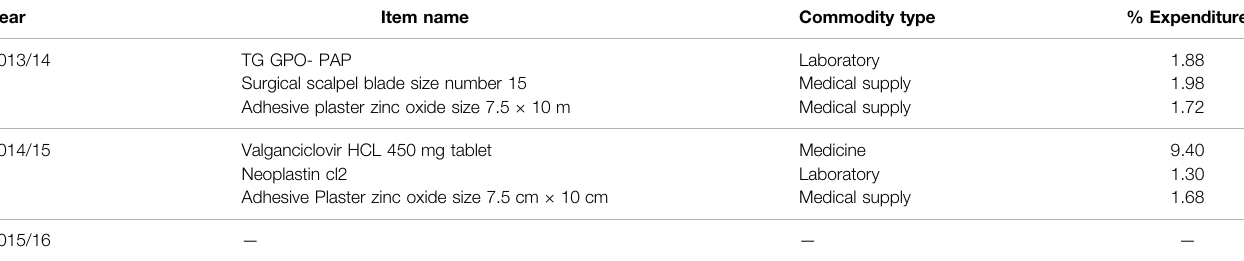
TABLE 5 | AN subgroups of category I Health Commodities in SPHMMC (2013/14-2015/16), March 2017.